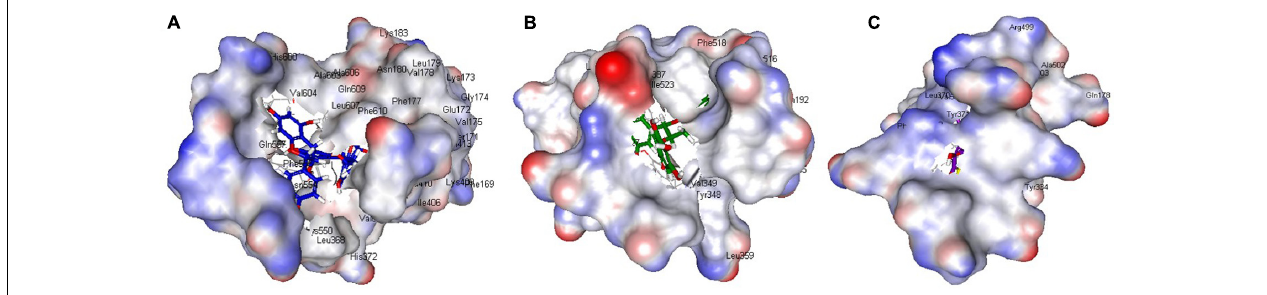
FIGURE 9 | (A) Active pockets showing epicatechin-epigallocatechin-epigallocatechin gallate in 5-LOX, (B) (epi)-gallocatechin gallate in COX-1, (C) myricetin rhamnoside in COX-2.